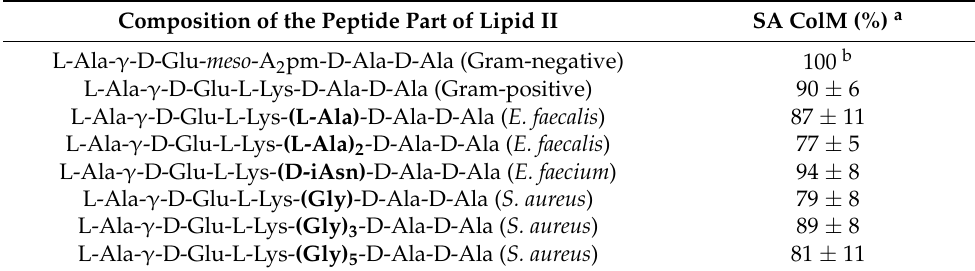
Table 2. Activity of ColM on ramified lipids II. The peptidic nature of the ramification is indicated in bold. The bacterial species corresponding to each lipid II is indicated in parentheses (after [55]). Composition of the Peptide Part of Lipid